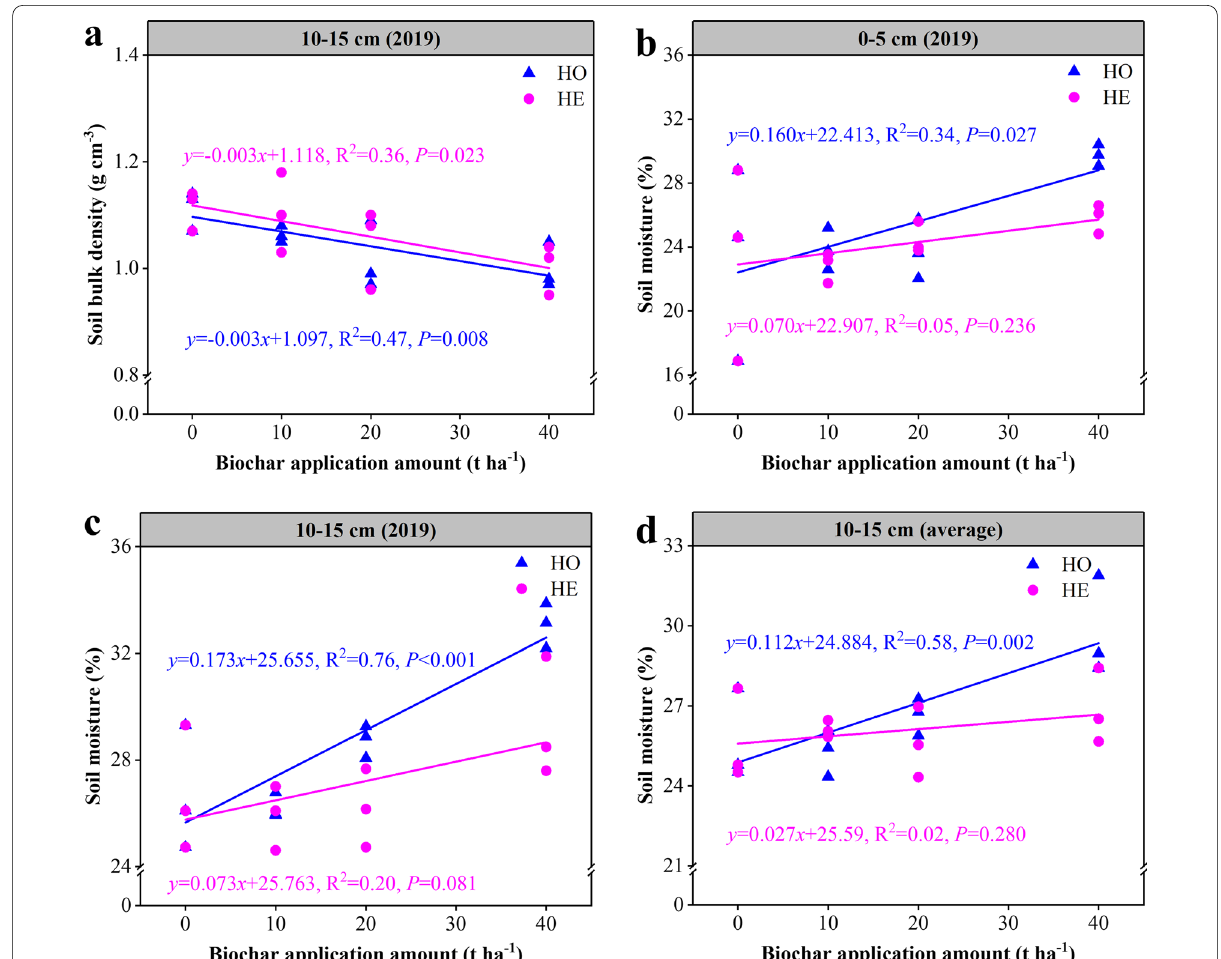
Fig. 2 The relationship between soil bulk, soil moisture and biochar application amount. a The relationship between bulk density in 10–15 cm soil layers and biochar application amount in 2019. b The relationship between moisture in 0–5 cm soil layers and biochar application amount in 2019. c The relationship between soil moisture in 10–15 cm soil layers and biochar application amount in 2019. d The relationship between average soil moisture in 10–15 cm soil layers and biochar application amount in 2019 and 2020. HO, homogeneous application; HE, heterogeneous